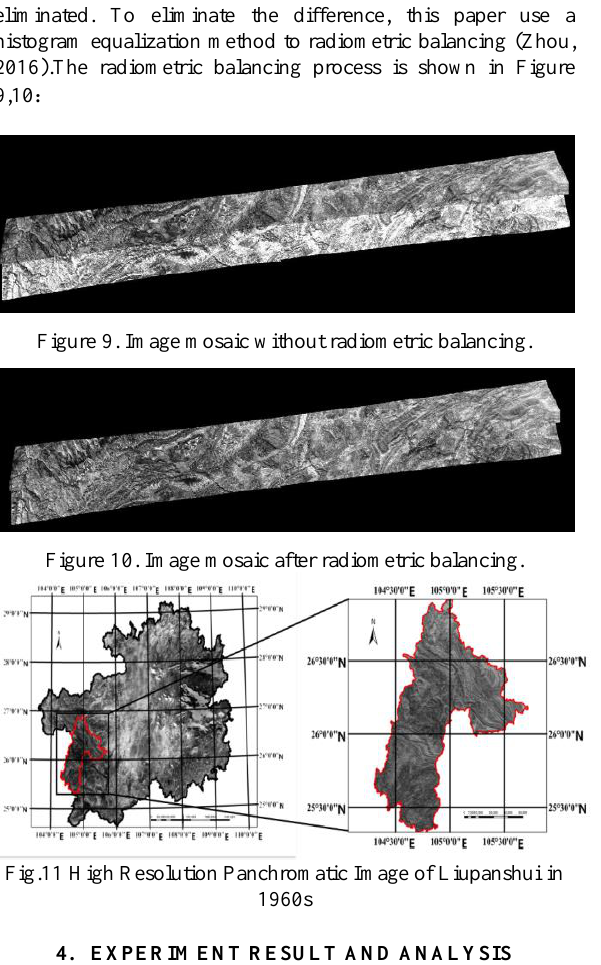
Figure 6. The selection of image seamline